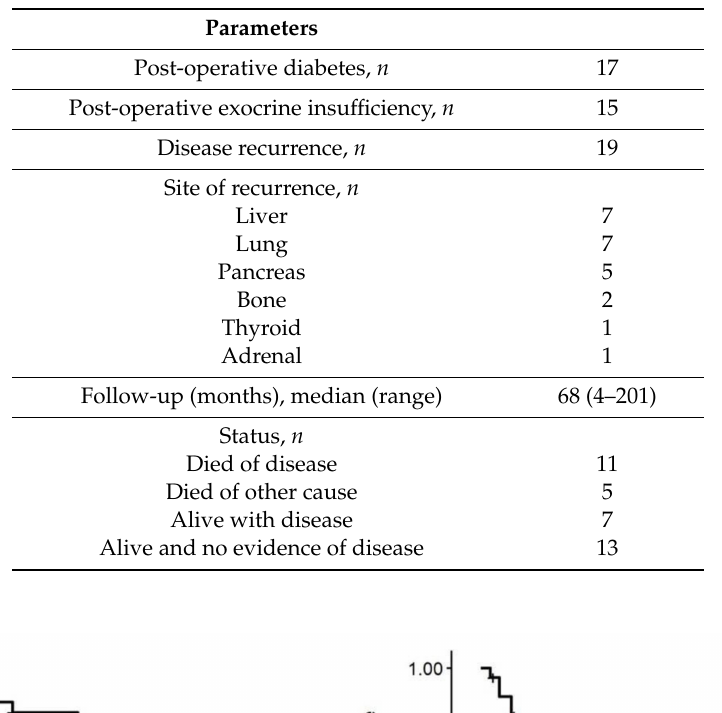
Table 2. Long-term follow-up ( n = 36).